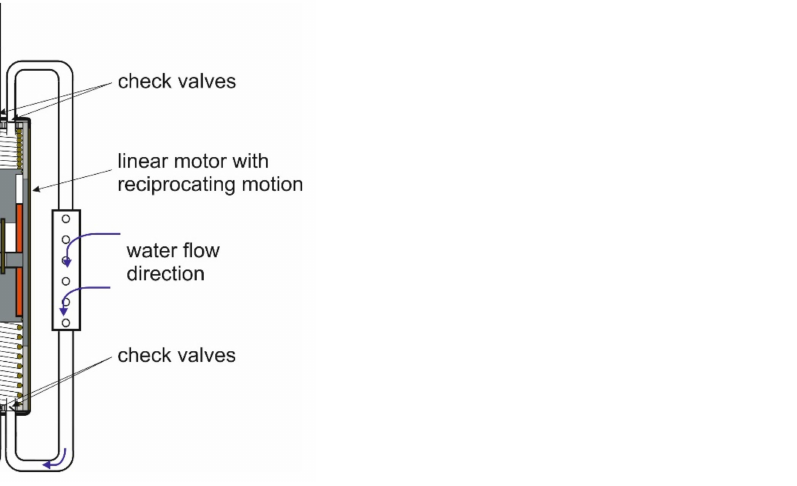
Figure 1. Diagram of a lift-and-force pump driven by a linear motor with reciprocating